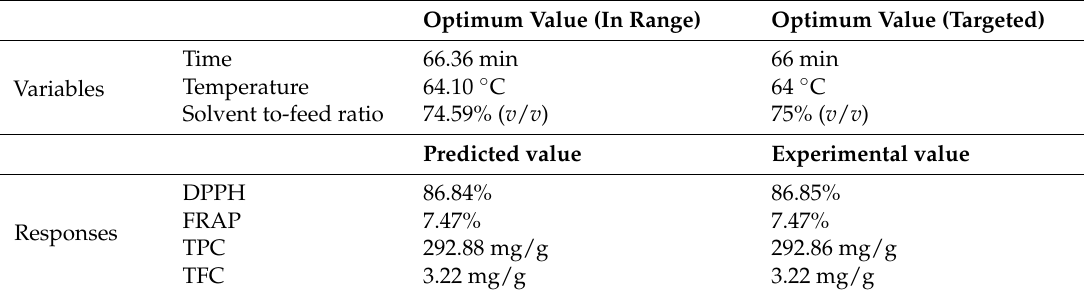
Table 4. Optimized level (in the range), optimum level (targeted), predicted optimum value and experimental value of DPPH, FRAP, TPC and